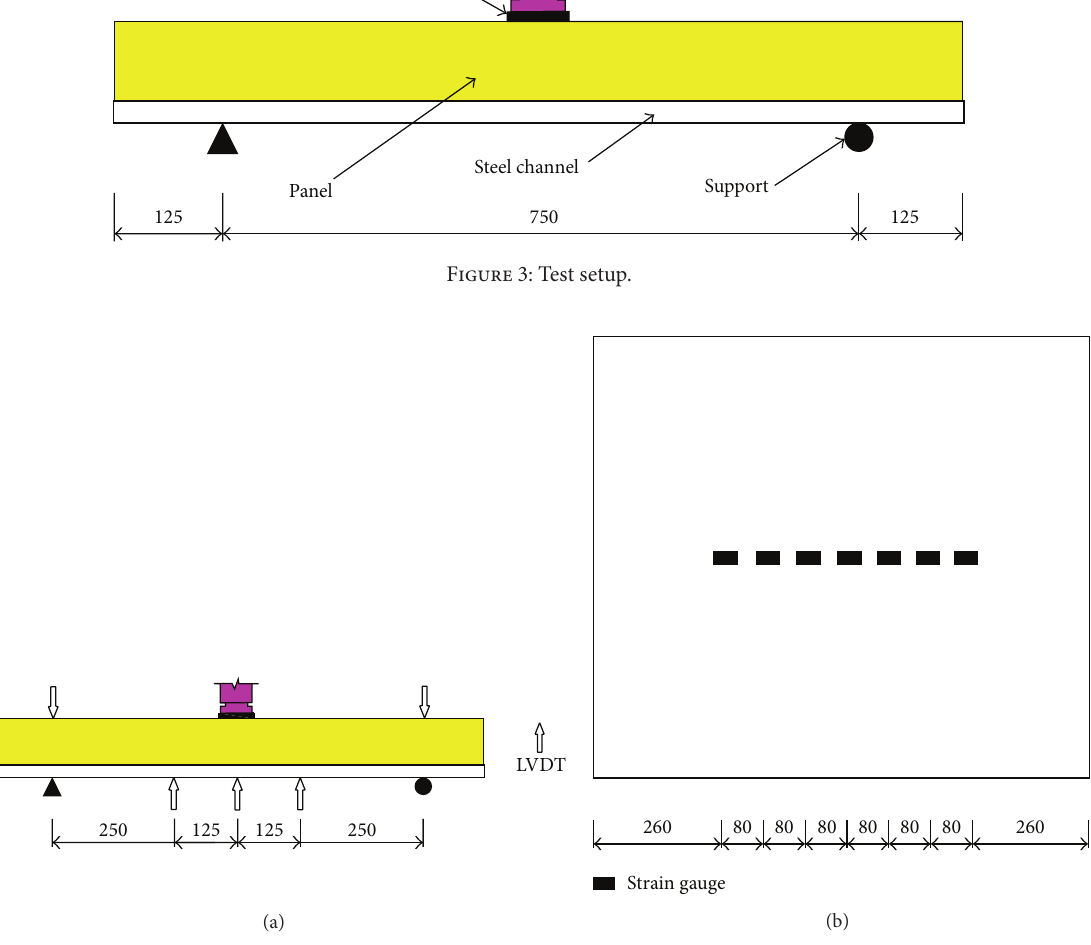
Figure 4: Instrumentation of Specimen P6S7W1T3: (a) LVDT and (b) strain gauge arrangements.